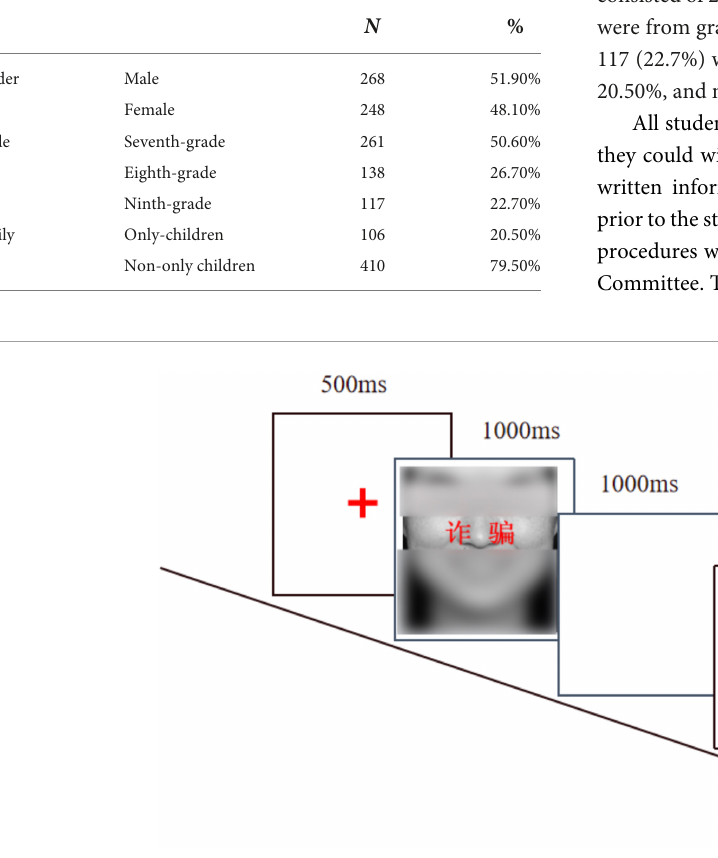
TABLE 1 Demographic characteristics of respondents.